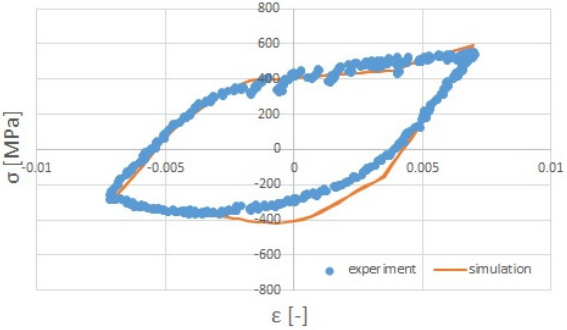
Figure 9. Comparison of measured and simulated mechanical response due to out-of-phase uniaxial me- chanical and thermal